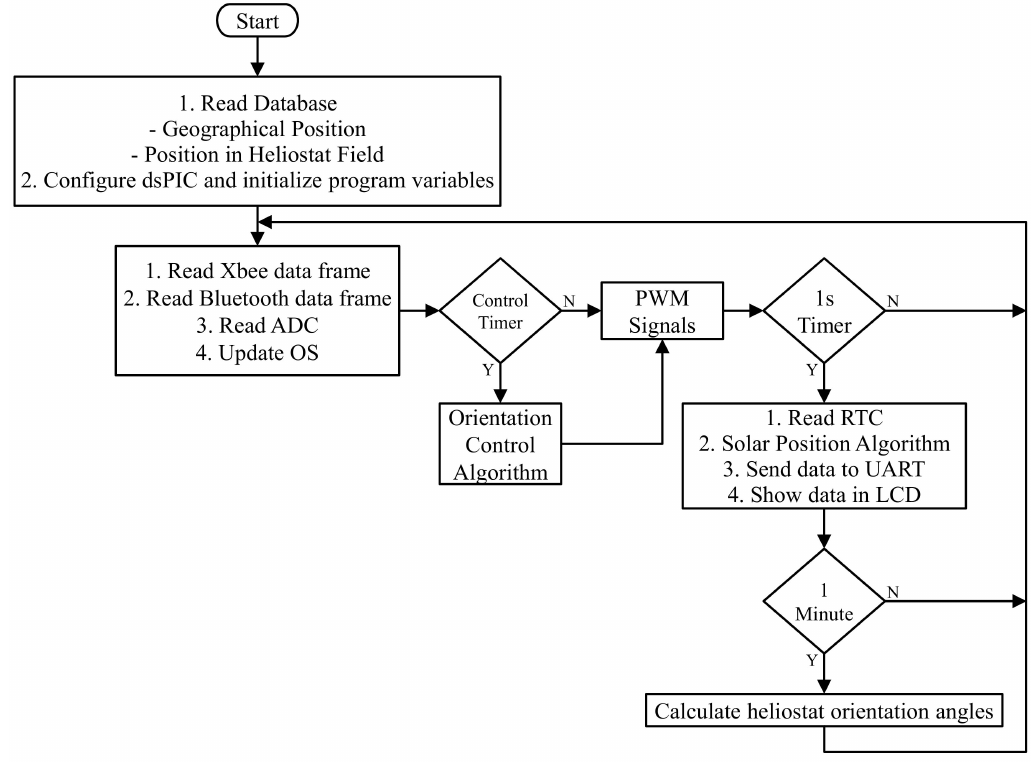
Figure 7. Control algorithm of the remote terminal unit. Table 3. Timers of the remote terminal unit